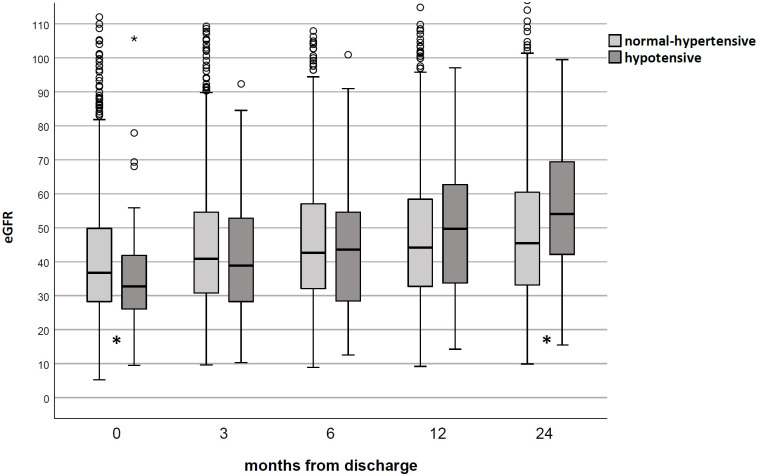
Renal function in studied population according to pre-existing blood pressure status.No difference was noted between the hypotensive and normal-hypertensive groups during the follow-up (p = N.S. at any time-point).